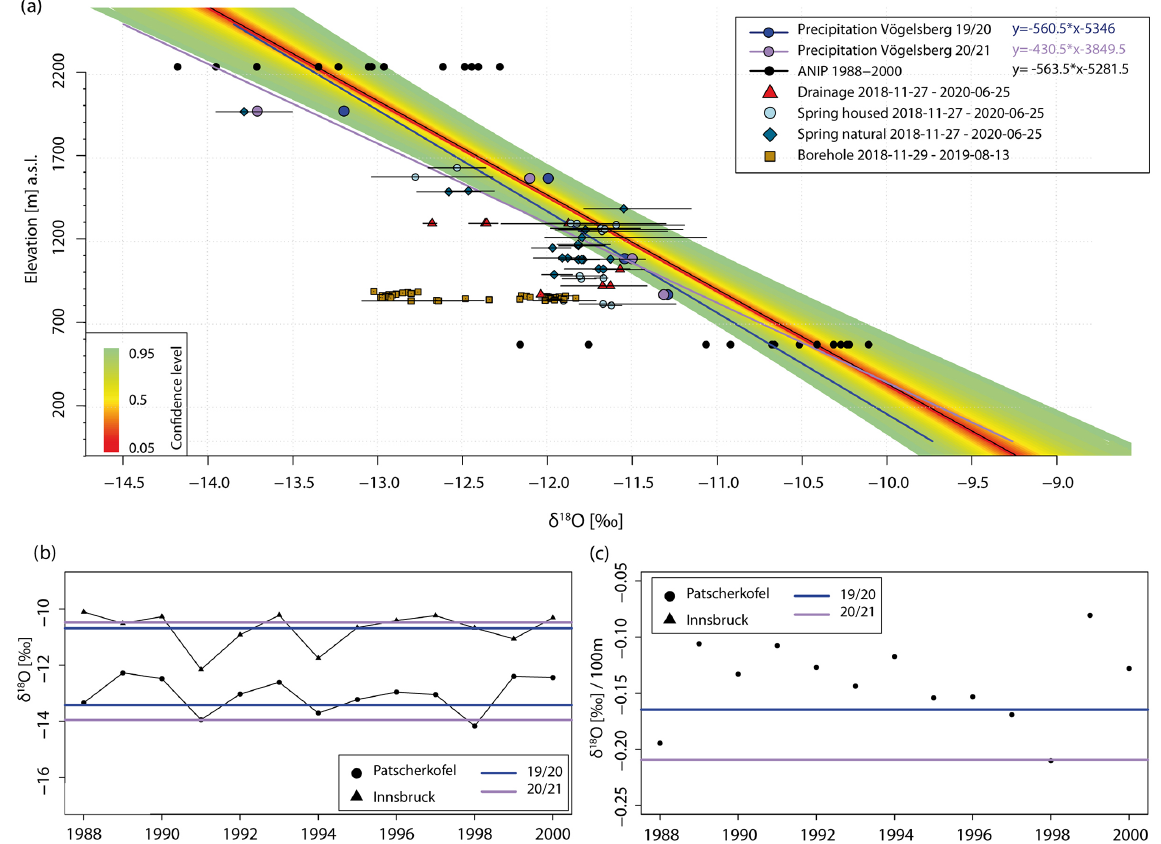
Figure 8. δ 18 O values and elevation of precipitation and groundwater samples. (a) Precipitation gradients, confidence interval, and groundwa- ter samples. (b) Time series of amount-weighted annual δ 18 O in precipitation at ANIP stations Patscherkofel and Innsbruck (data retrieved from https://wasser.umweltbundesamt.at/h2odb/, last access: 20 December 2021). Annual δ 18 O values (extrapolated to the corresponding ANIP station elevation) of the study are shown by horizontal lines. (c) Time series of annual δ 18 O-precipitation